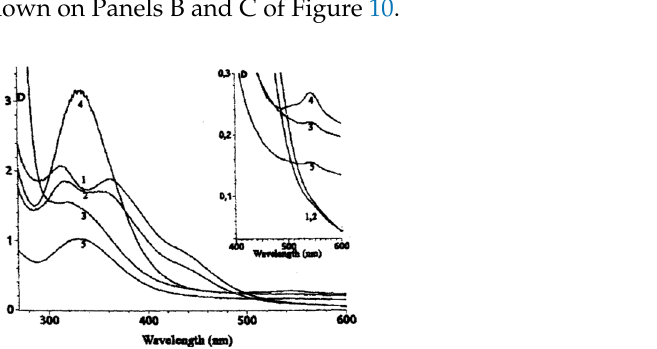
Figure 11. Optical absorption spectra of B-DNIC-GSH solutions (5 mM), with molar ratios of “free glutathione” and B-DNIC-GSH of 2: 1 (curve 1) or 1: 1 (curve 2). The solutions were diluted ten times. Curves 3 and 4—the absorption spectra of GS-NO were registered in 5 mM solutions of the same B-DNICs heated at 80 °C with pH = 1.0 in anaerobic conditions for 8–9 min, without being diluted. The spectra are characterized by the absorption band at 334 nm slightly shifted to the short-wave region? And the weak band at 543 nm. Curve 5—the absorption spectrum of the solution, characterizing by curve 4, after diluting that solution four times. The inset shows the spectra registered at higher spectrometer sensitivity in the band absorption region at 543 nm [87]. (With permission).